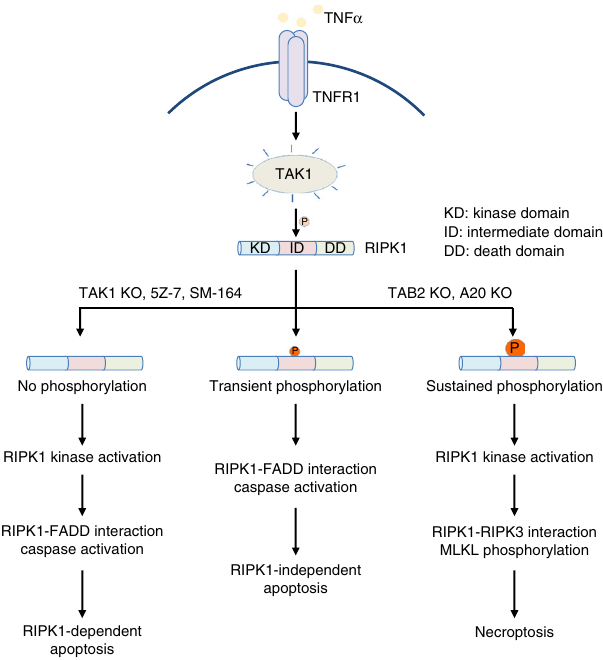
Fig. 8 TAK1-mediated RIPK1 phosphorylation dictates the activation multiple cell death pathways. Upon TNF α treatment, TAK1 is activated to mediate RIPK1 phosphorylation on the intermediate domain. Under